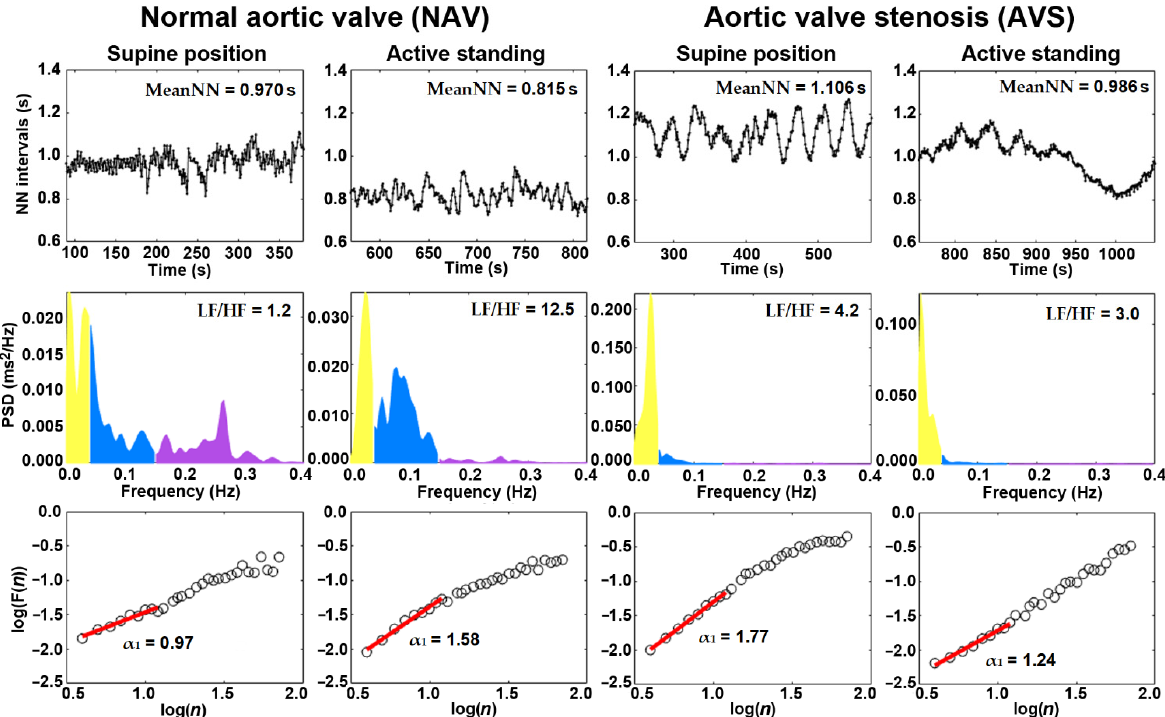
Figure 1. Example of time series (upper panel), power spectrum density (middle panel) and detrended fluctuation analysis (DFA) plot (low panel) from one participant with normal aortic valve (NAV) and one patient with aortic stenosis (AVS). MeanNN: mean value of all NN intervals; PSD: power spectral density; LF/HF: ratio between low-frequency (LF) band and high-frequency (HF) band indices; α 1 : short-term scaling index (from the DFA plot).